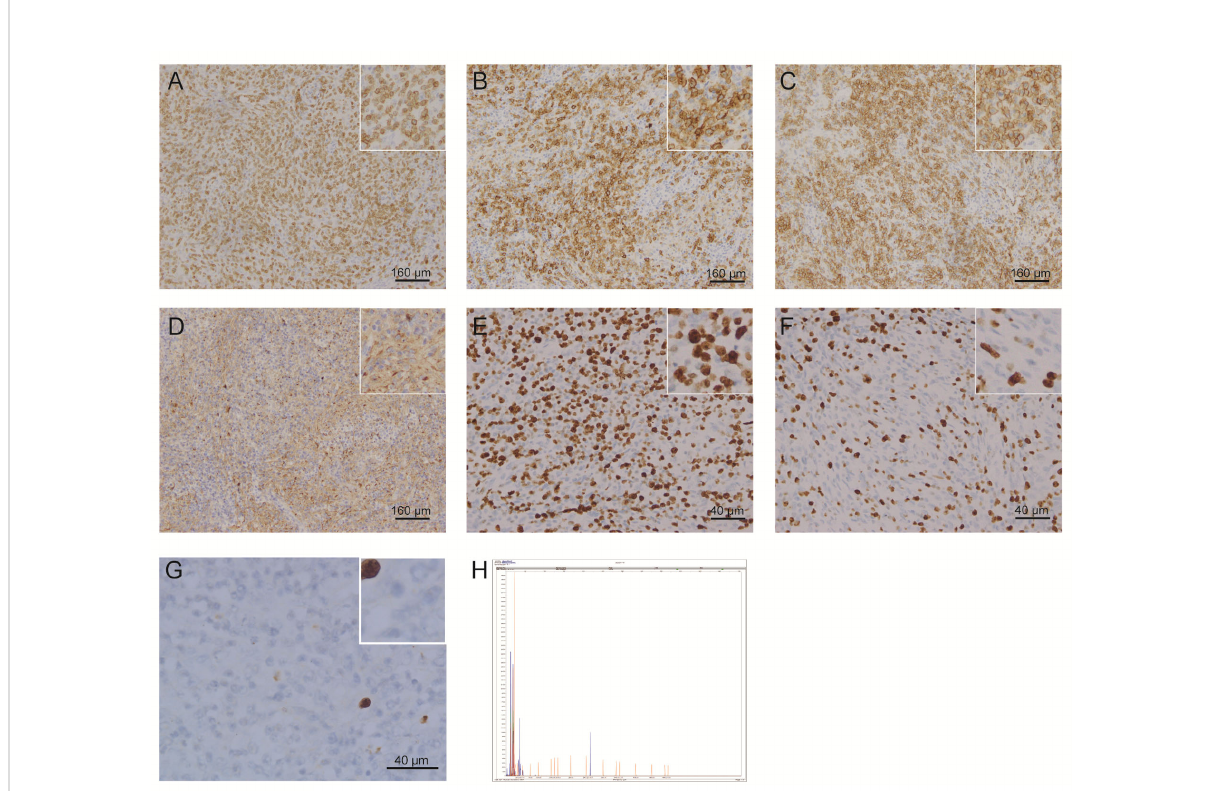
FIGURE 4 Representative IHC staining images and detection of clonal rearrangement of the TCR gene in lymphoid tumor cells. Lymphoid tumor cells were positive for (A) CD3, (B) CD10, (C) PD-1, and (D) CXCL13. (E, F) Lymphoid tumor cells were positive for Ki-67, while most of the spindle cells were negative for Ki-67 staining. (G) A few scattered immunoblastic large cells were positive for EBER. (H) Clonal rearrangement of TCR b was observed. (IHC, immunohistochemistry; TCR, T cell receptor; PD-1, programmed cell death 1; CXCL13, C-X-C motif chemokine ligand 13; EBER, Epstein-Barr virus encoded small